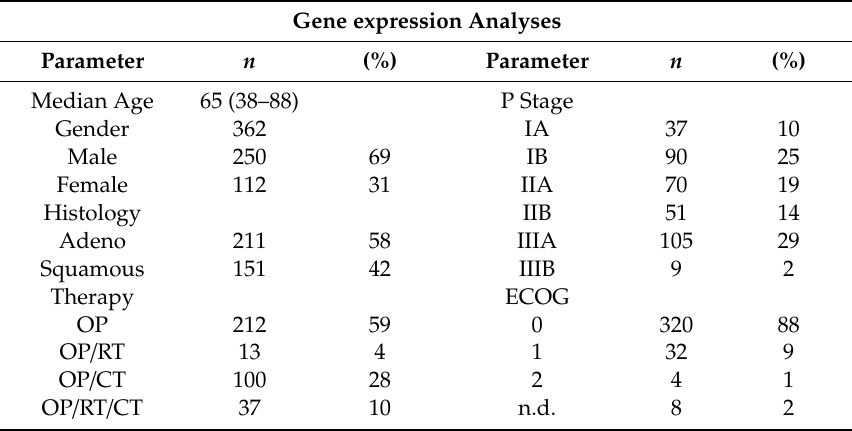
Table 1. Patient characteristics of the cohort investigated in the